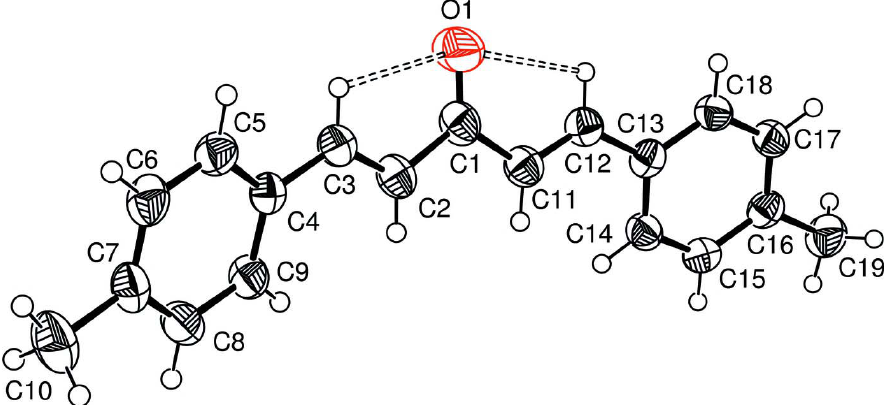
were averaged before the final refinement as the absolute configuration could not be determined unambiguously.